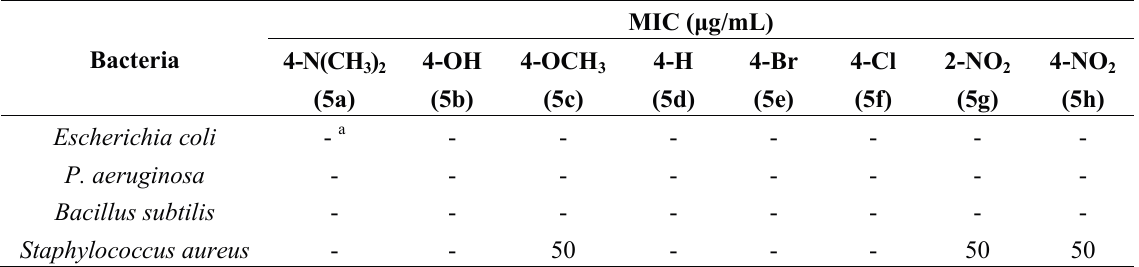
Table 2. The minimum inhibitory concentrations (MICs) of 5a – h against